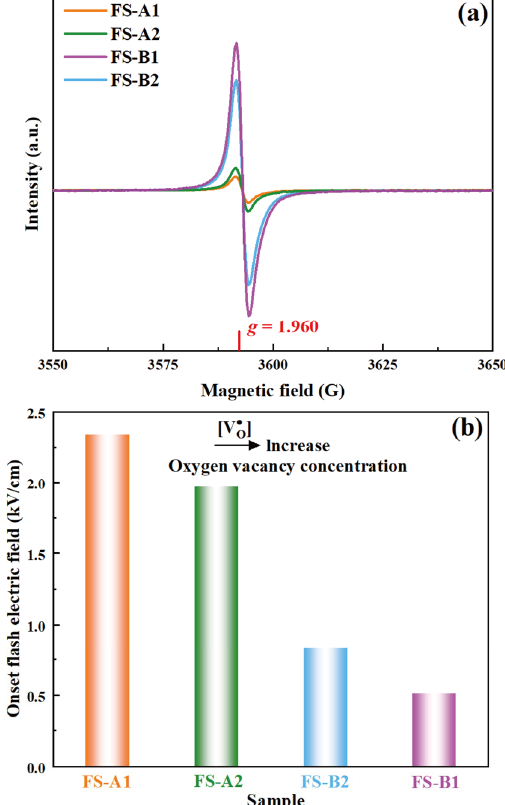
Fig. 4 (a) EPR spectra; (b) onset flash electric fields for samples with different oxygen vacancy